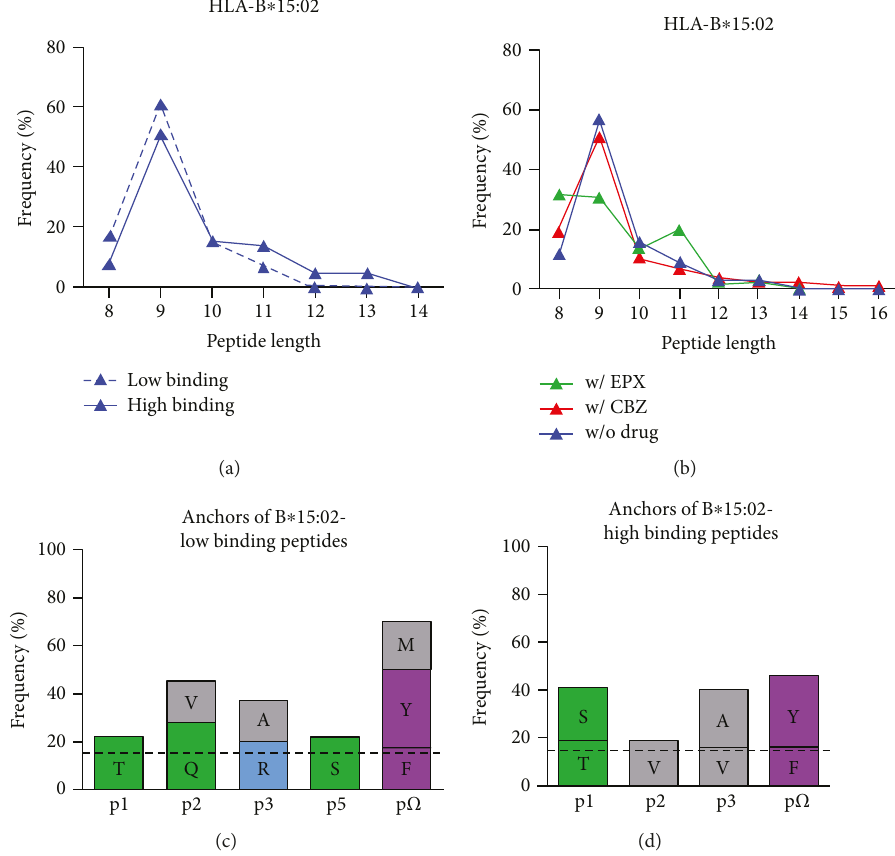
Figure 1: Characteristics of peptides presented by HLA-B ∗ 15:02. (a) Length distribution of low and high binding peptides presented by HLA- B ∗ 15:02. (b) Length distribution of peptides presented by HLA-B ∗ 15:02 without treatment (blue), after incubation with CBZ (red) and EPX (green). (c) Preferred AAs of low binding peptides presented by HLA-B ∗ 15:02. (d) Preferred AAs of high binding peptides presented by HLA- B ∗ 15:02. All AAs with a frequency higher than 15% (dashed line) are given for position p1-p3, p5, and p Ω . AAs are distinguished into polar positive (blue), polar neutral (green), nonpolar aliphatic (grey), and nonpolar aromatic (purple)